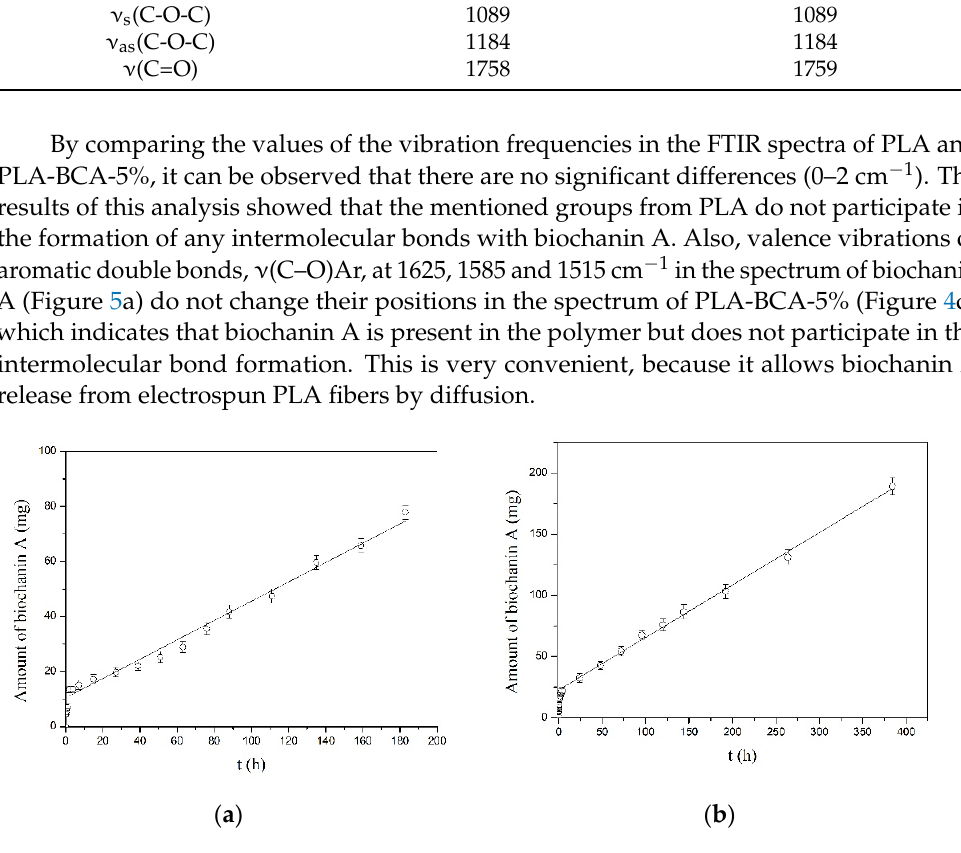
Figure 5. Amount of biochanin A released from ( a ) electrospun PLA-BCA-2% and ( b ) electrospun PLA-BCA-5% fibers in buffer at pH 7.4 and temperature of 37 ° C.